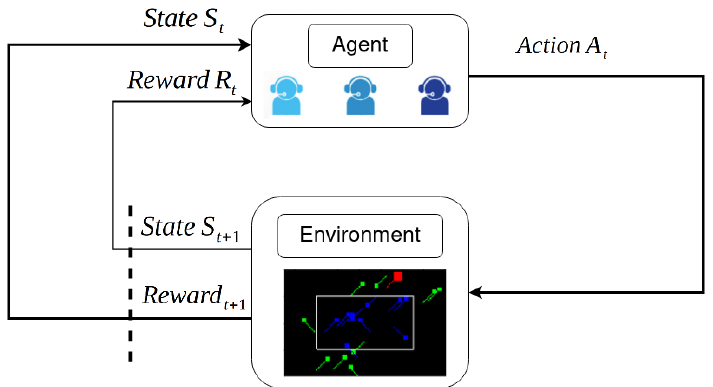
Figure 1. Interaction between the different elements in a RL system (adapted from